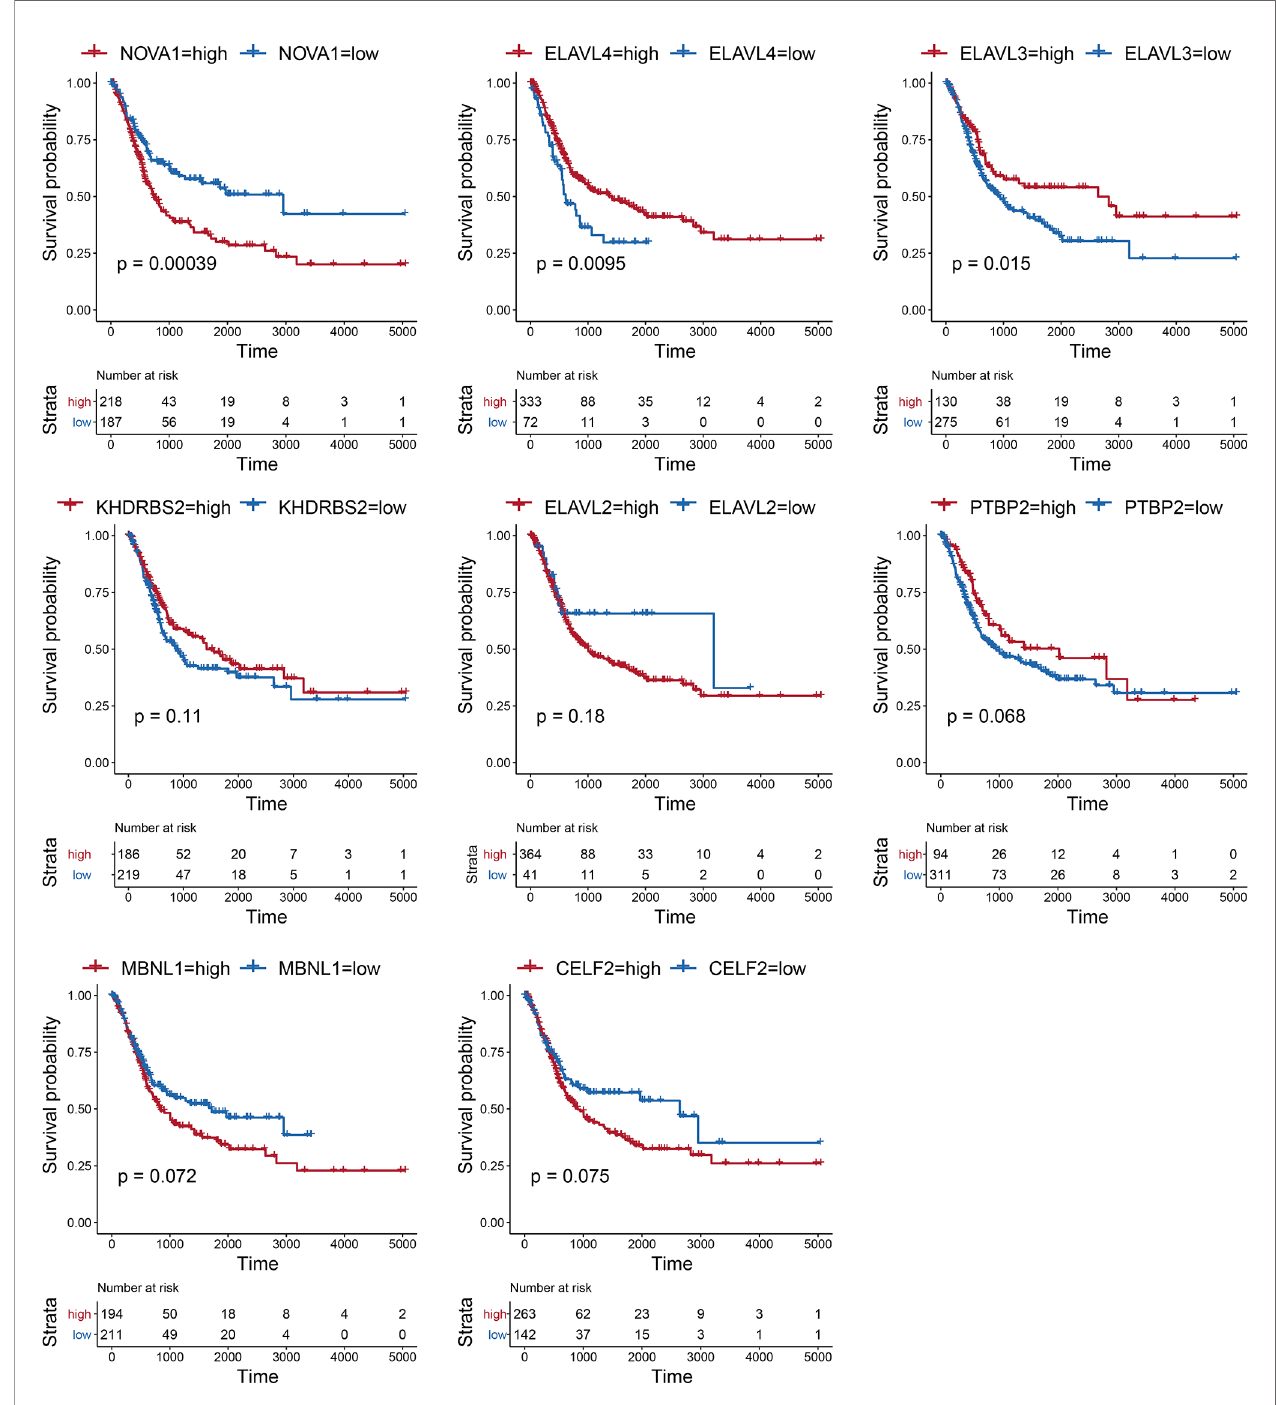
FIGURE 7 | Kaplan – Meier survival curve for eight hub